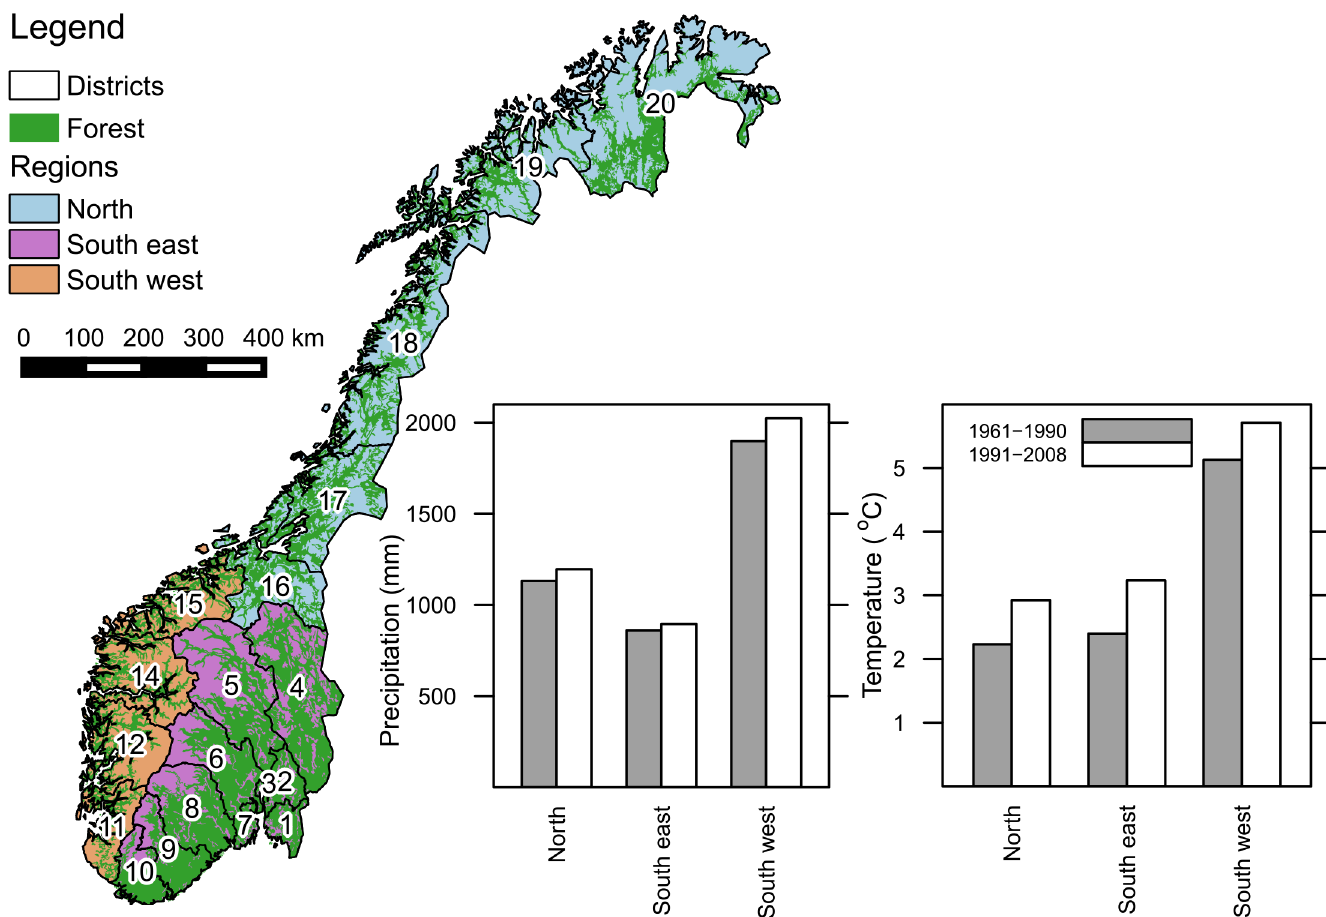
Fig 1. Forest area and regional climate in Norway. The forest is distributed throughout the country, but the majority is found in the southeastern and central parts (left panel). Mean annual temperature and mean annual precipitation in the three regions indicate a warmer and slightly wetter climate more recently than prior to